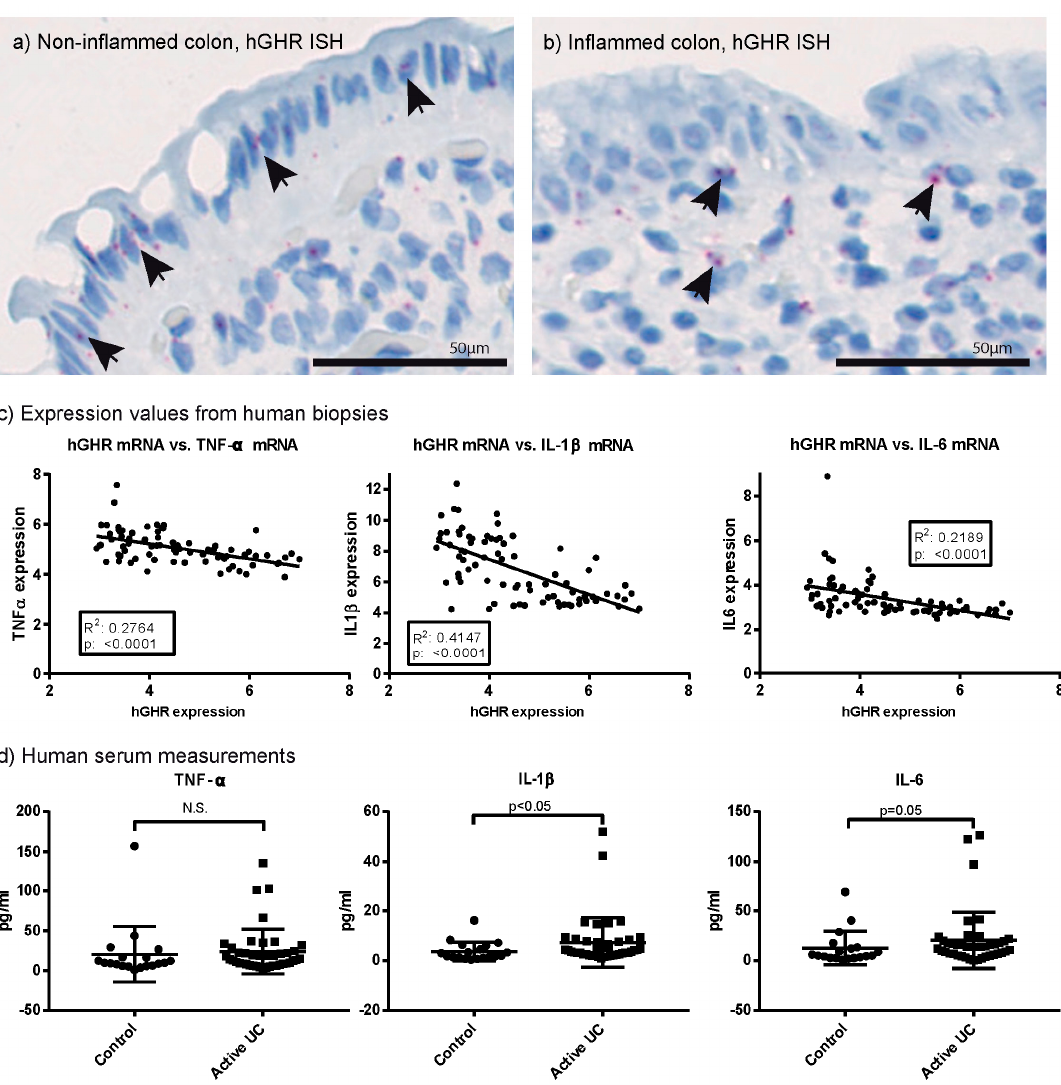
Figure 2. Expression of hGHR in human colon visualized by in situ hybridization in non-inflamed ( a ) and inflamed ( b ) UC specimens. Arrows indicate positively stained cells; ( c ) Correlation between the expression level of hGHR versus the expression of tumor necrosis factor (TNF)- α , interleukin (IL)-1 β and IL-6 in colonic biopsies from the patient cohort (microarray data, log 2 -scale); ( d ) Serum measurements of TNF- α , IL-1 β and IL-6 from non-inflammatory bowel disease (IBD) controls and patients with active UC. Data presented as mean ± SD. ISH: in situ hybridization. N.S.: not statistically